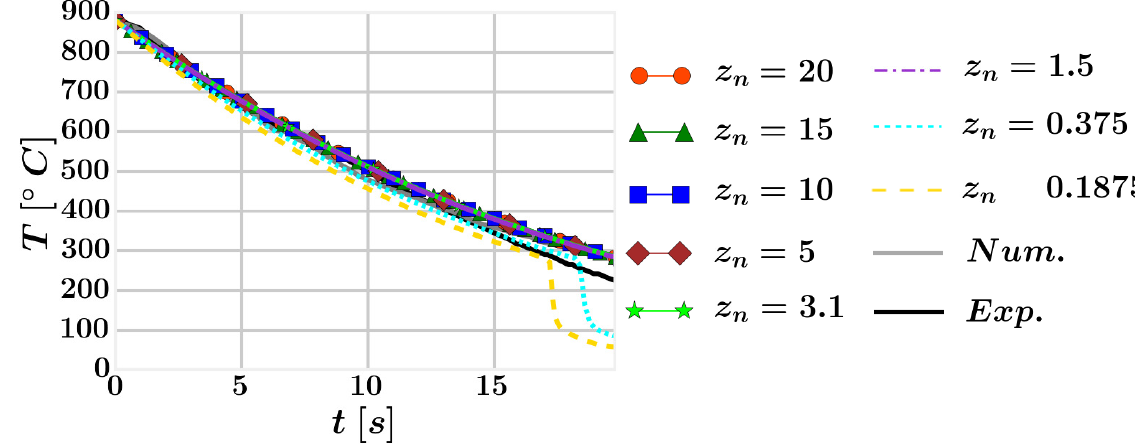
Figure 9. Cooling curves acquired at the location L 2 using various fluid meshes. The interfacial phase change is allowed and validation data are